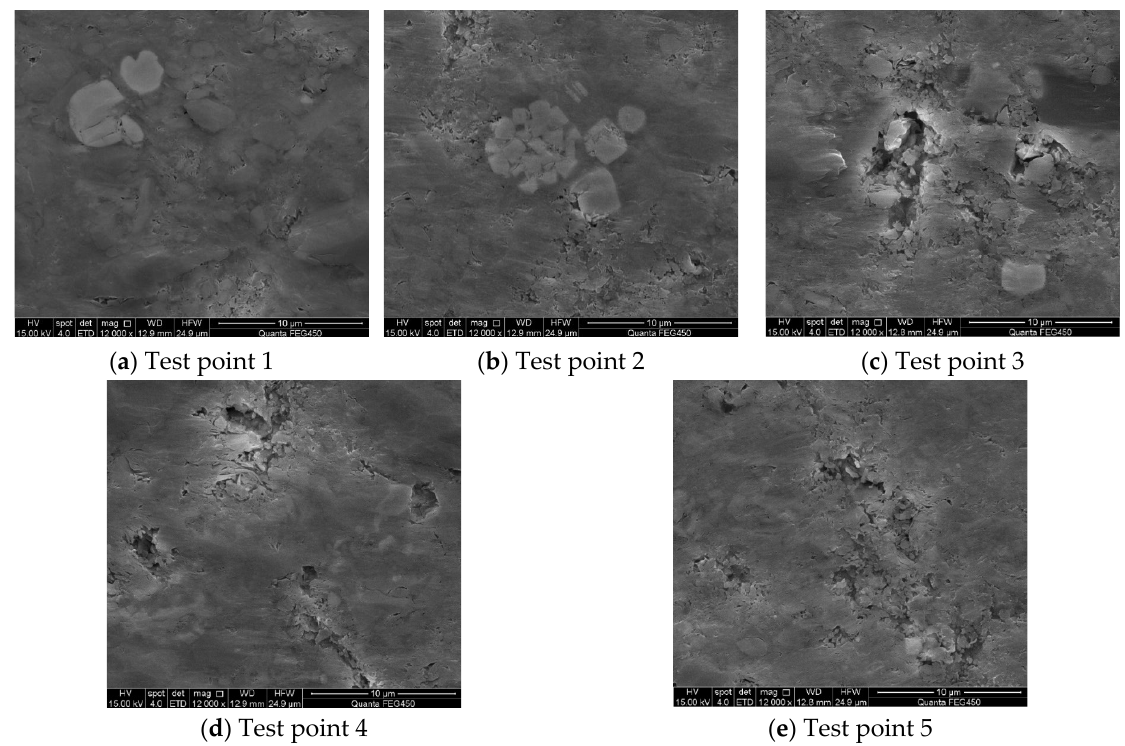
Figure 5. SEM image of CZ-Y47-1 in the direction perpendicular #2 to the bedding plane.